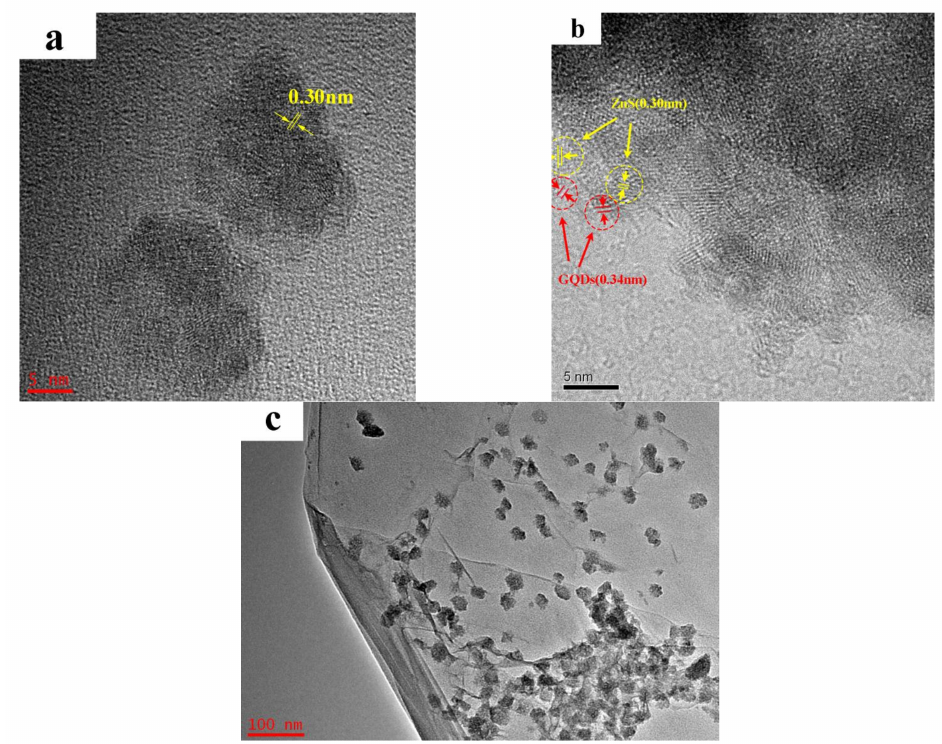
Figure 3. TEM images of ZnS-graphene ( a ) and ZnS-GQDs ( b , c ) composites.